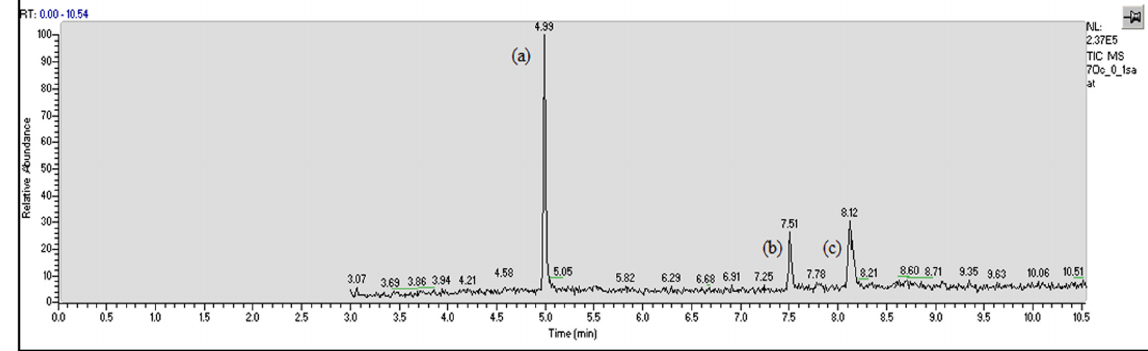
Figure 1: GC-MS chromatograms of derivatives (a) internal standard (5α-cholestane); (b) stigmasterol; (c)